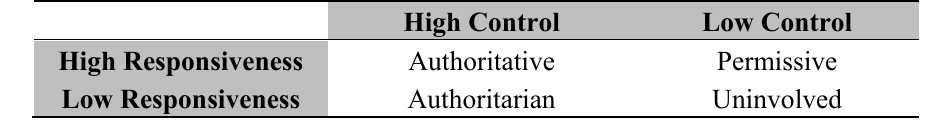
Table 1. Parenting